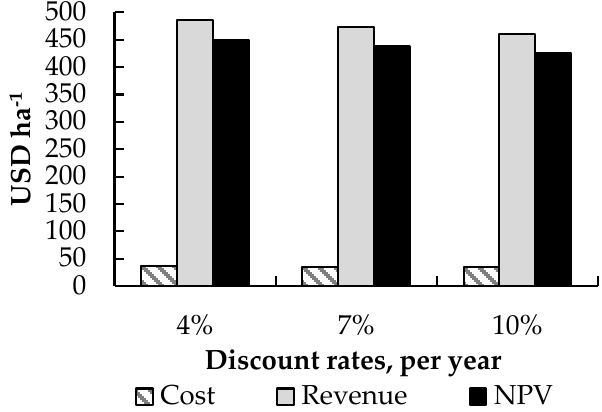
Figure 3. Cash flow and net present value ( NPV ) (USD ha − 1 ) with discount rates, from 4% to 10% per year, for the forest management activity submitted to harvest criteria at Shet Farm, in Dom Eliseu, Par á ,